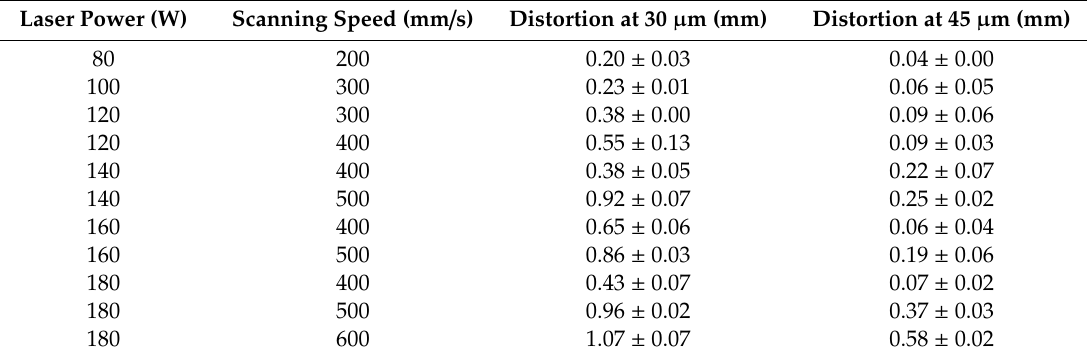
Table 4. Distortion comparison for the layer thicknesses